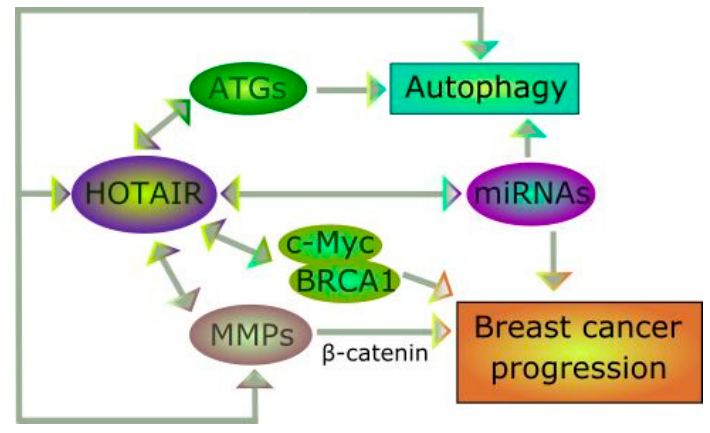
Figure 5. The HOTAIR–breast cancer–autophagy cross-talk. HOTAIR regulates many miRNAs and several miRNAs can be important for HOTAIR functions. These miRNAs include species important for autophagy regulation and cancer progression, but these processes can be regulated by HOTAIR in different pathways involving interaction with autophagy-related (ATG) proteins and matrix metalloproteinases (MMPs), respectively. Many other proteins can be involved in this cross-talk, including the c-Myc and BRCA1 oncoproteins, essential for breast cancer.